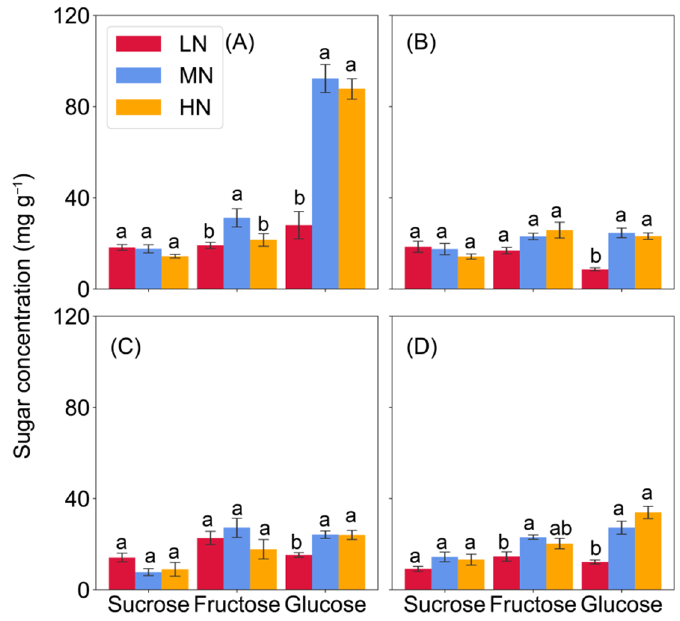
Figure 3. Sugar concentrations in the nodes of maize plants under low, medium, and high nitrogen supply at 62 days after sowing. ( A ) Stem base node (node 1); ( B , C ) two nodes above the stem base node (Nodes 2 and 3, respectively); ( D ), Node 8 where the 8th leaf is located. Vertical bars indicate the standard error of the mean ( n = 4). Different letters above the columns in each panel represent significant differences between nitrogen treatments for each sugar ( p < 0.05). LN, no nitrogen application; MN, 0.15 g N kg − 1 ; HN, 0.30 g N kg − 1